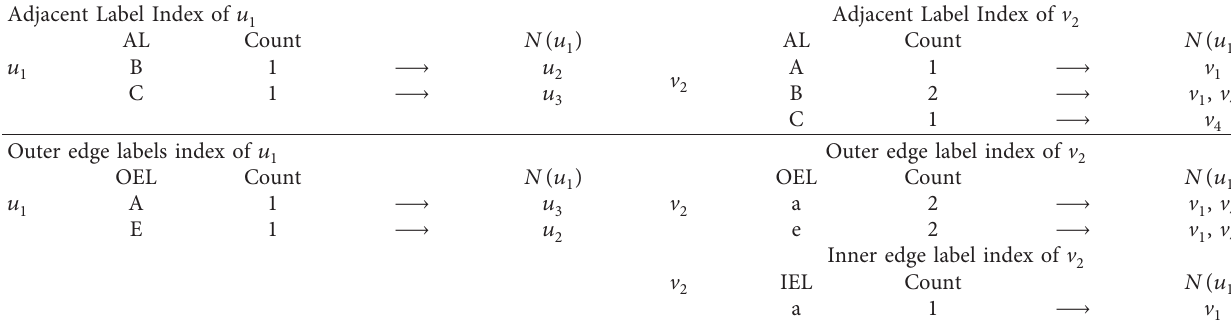
Figure 4: (a) Matching tree. (b) Flow graph. Table 2: Adjacent indexes of query and data